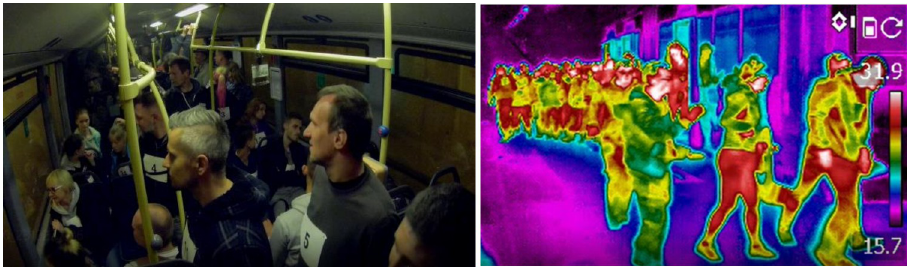
Fig 4. Participants in the bus and main tunnel during one of the experiments in Gda ń sk.